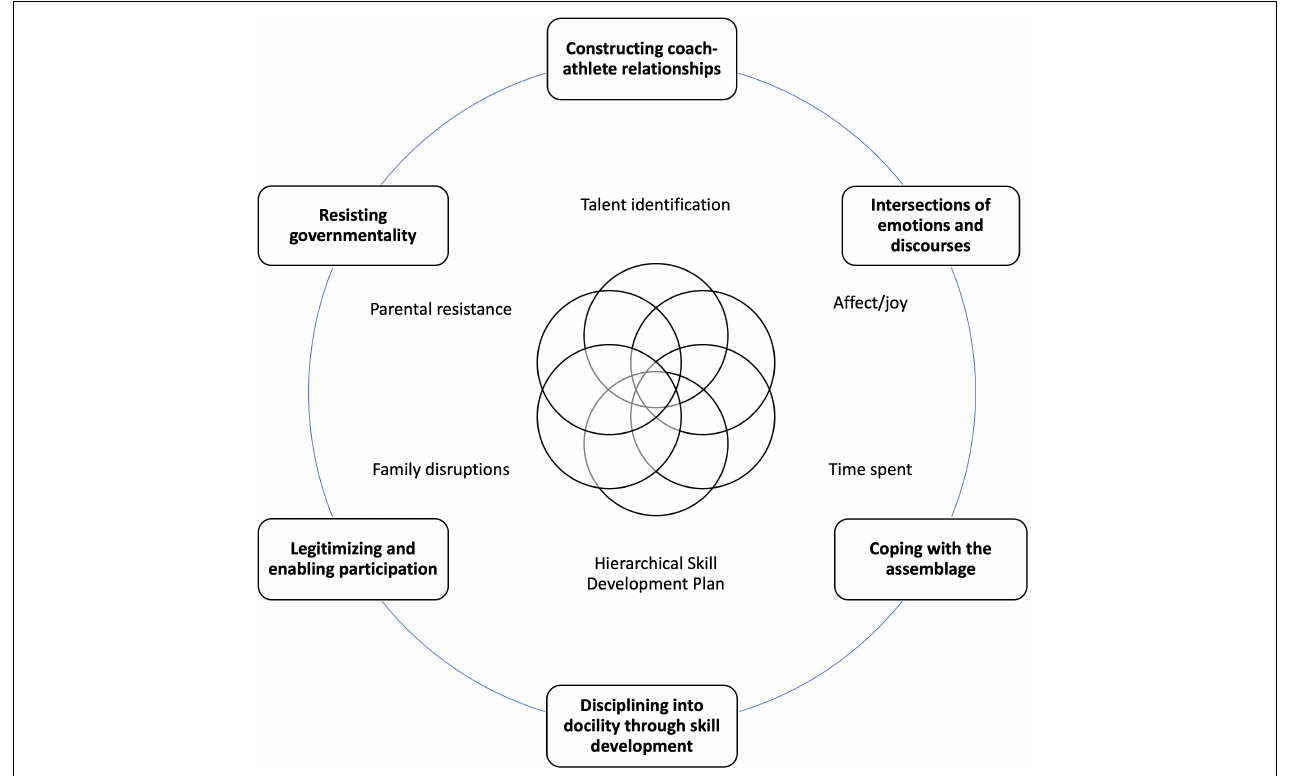
FIGURE 1 | Assemblage of the socialization of